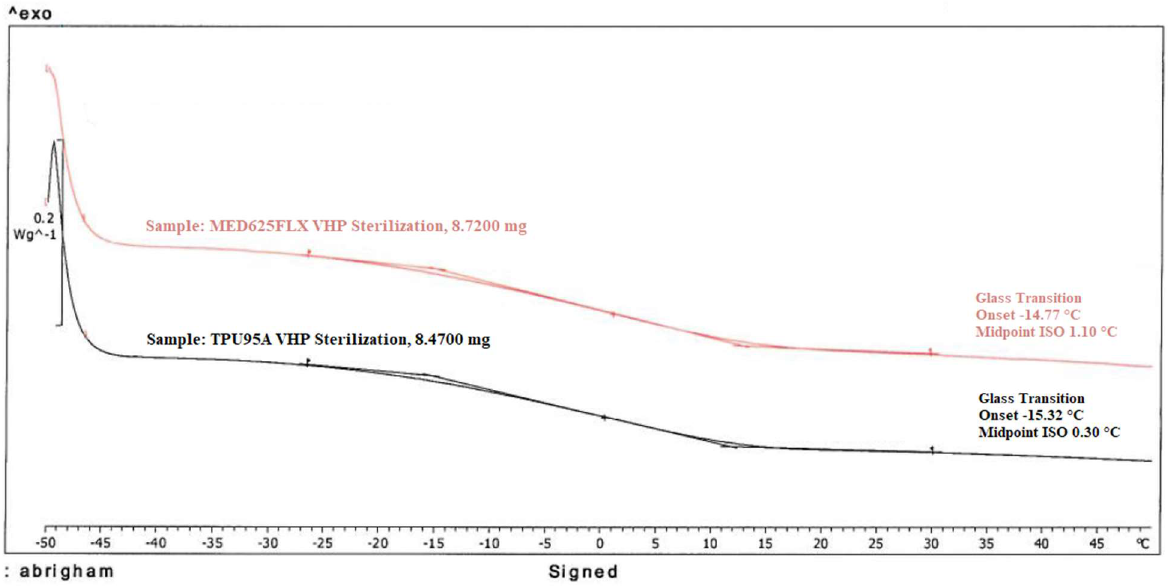
Figure 5. Low-temperature DSC of biomaterials. The graph represents the low-temperature DSC behavior of both MED625FLX (with a sample of 8.7200 mg) and TPU95A (with a sample of 8.4700 mg) after VHP sterilization.